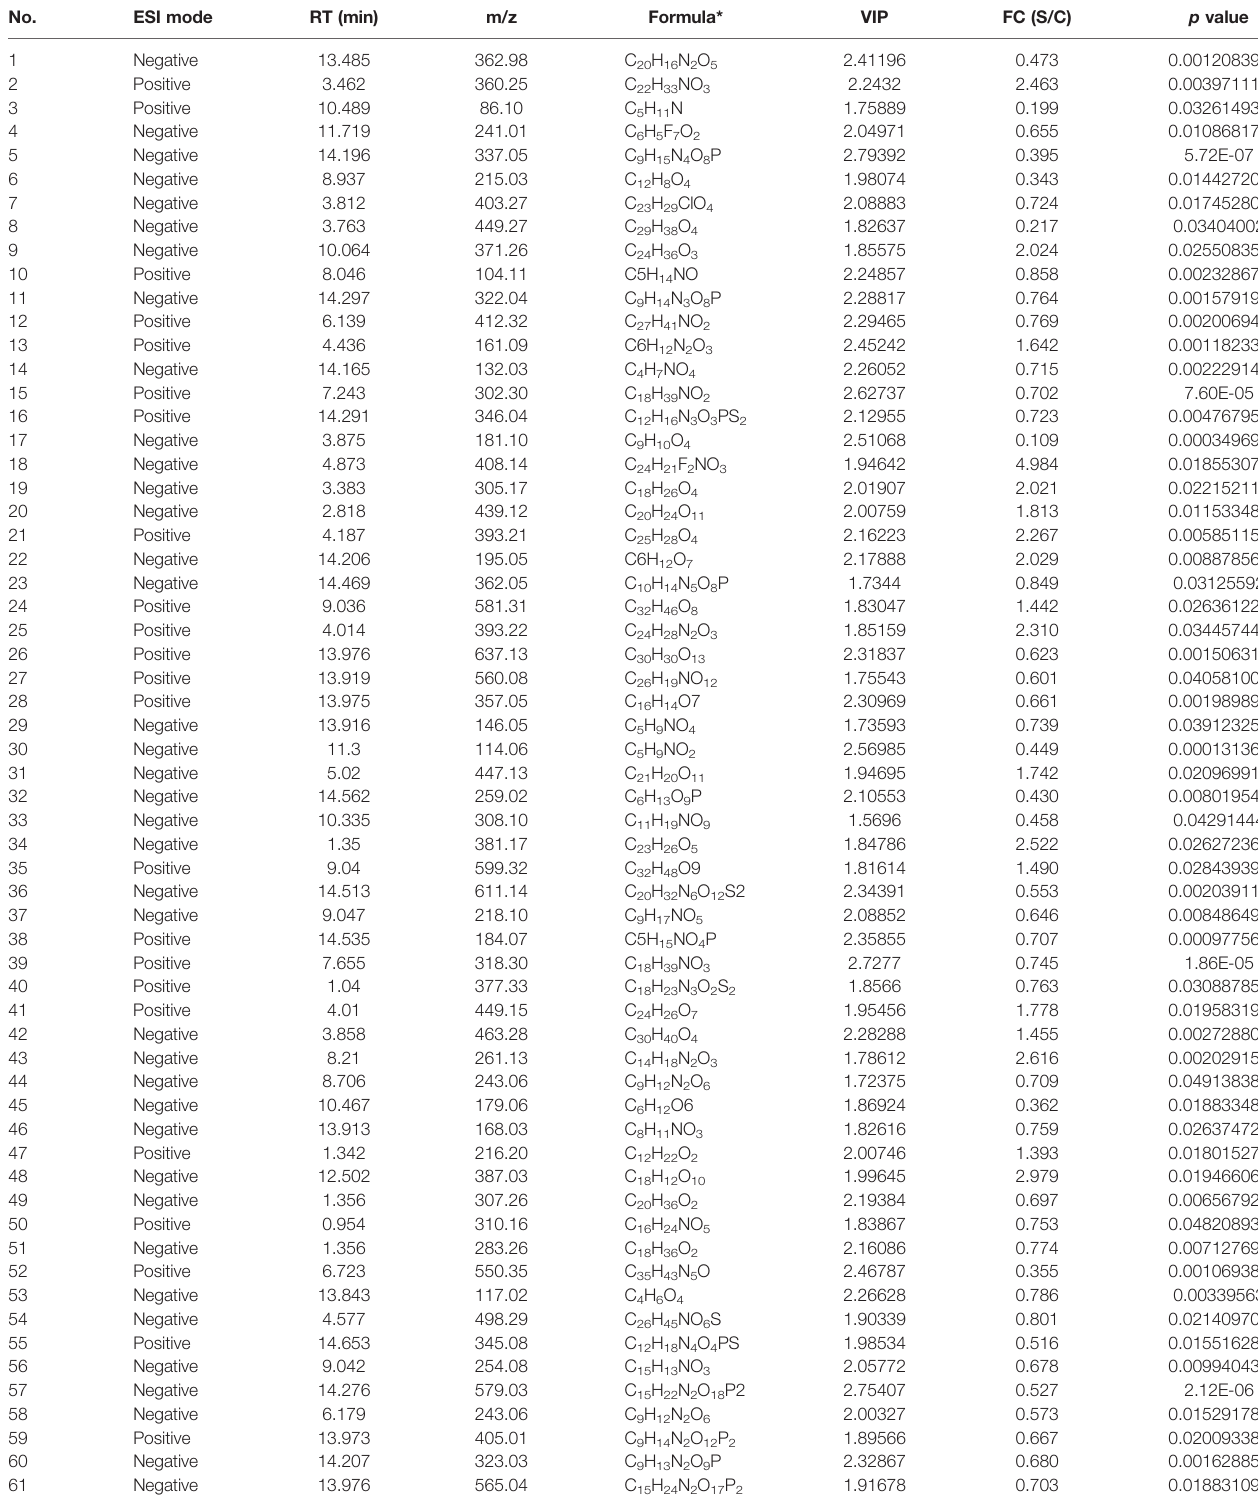
TABLE 1 | Metabolites with signi fi cantly different values (VIP > 1 and p value < 0.05) between SVA- and non-infected BSR-T7/5 cells.